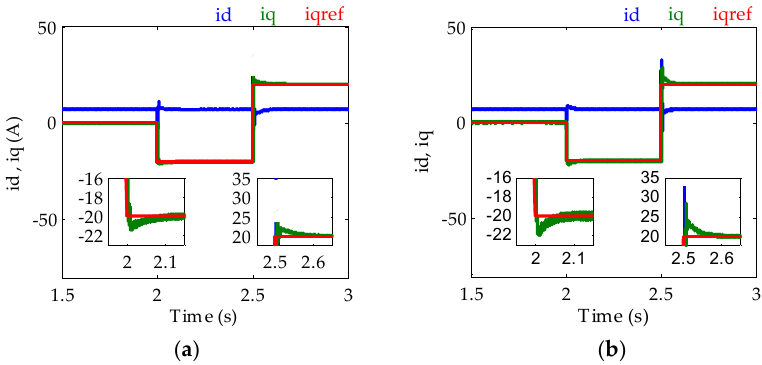
Figure 8. Simulation waveforms of the active and reactive current of the CHBR under different working conditions by the use of ( a ) the proposed control strategy and ( b ) the conventional control strategy.